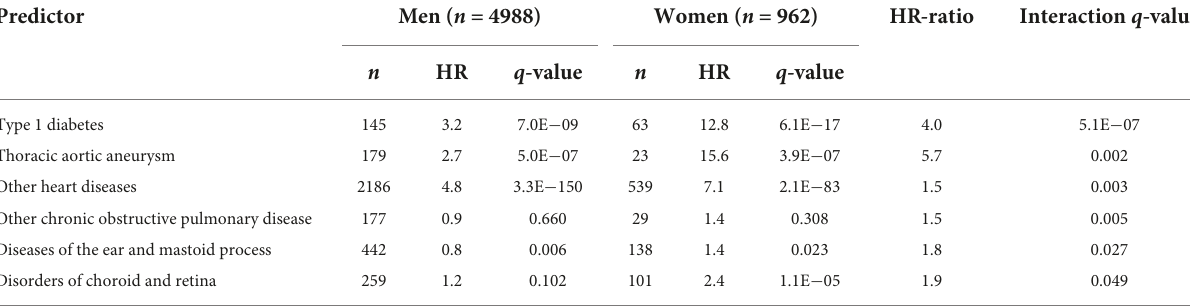
TABLE 1 Predictors with sex related risk prior to coronary artery bypass grafting (CABG).